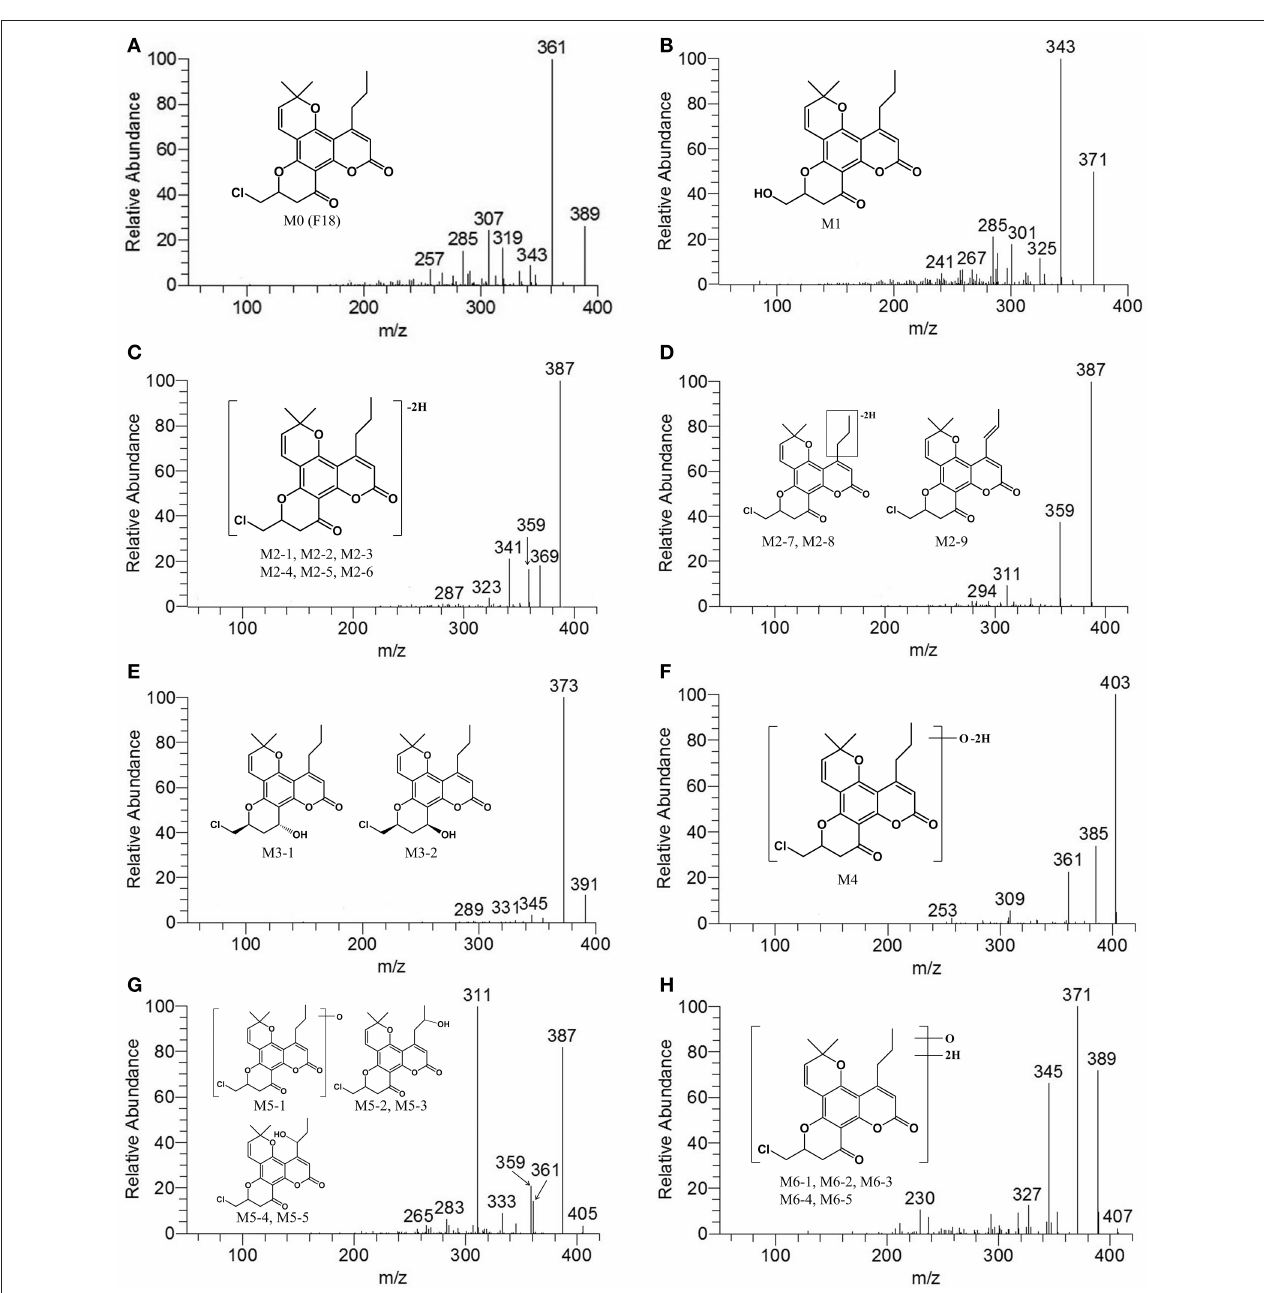
FIGURE 3 | MS 2 spectra of F18 and its metabolites in HLM incubation in the presence of a NADPH-generating system. (A) , F18 ( m/z 389); (B) , M1 ( m/z 371); (C) , M2-1, M2-2, M2-3, M2-4, M2-5, and M2-6 ( m/z 387); (D) , M2-7, M2-8, and M2-9 ( m/z 387); (E) , M3-1 and M3-2 ( m/z 391); (F) , M4 ( m/z 403); (G) , M5-1, M5-2, M5-3, M5-4, and M5-5 ( m/z 405); and (H) , M6-1, M6-2, M6-3, M6-4, and M6-5 ( m/z 407). MS 2 data were obtained from the respective [M + H] + ions as the precursors for collision-induced dissociation.